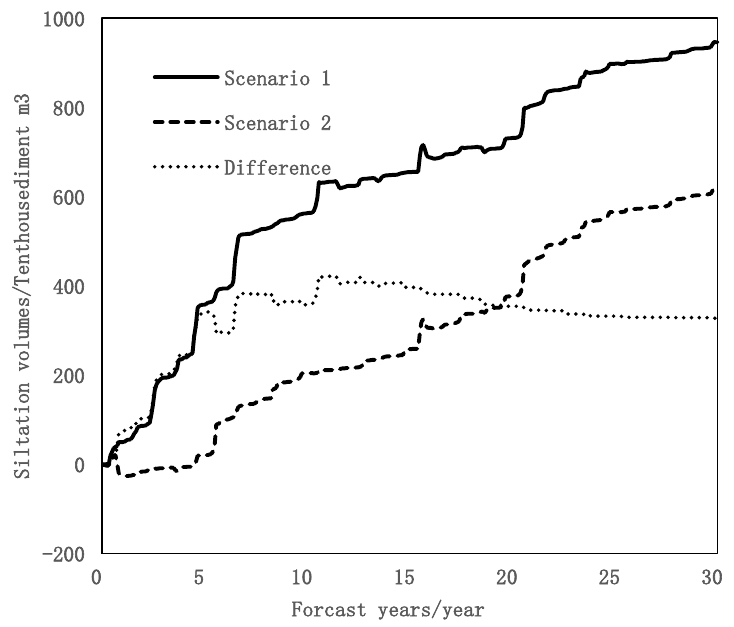
Figure 4. Cumulative deposition process in Wanglin section under two flow–sediment series.